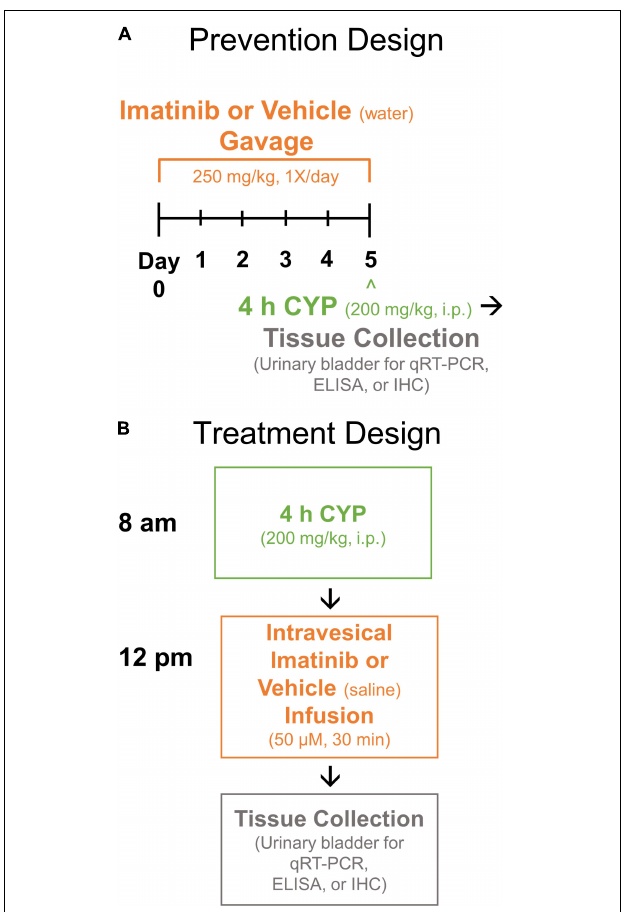
FIGURE 1 | Experimental designs. (A) Prevention design. Mice were pre-treated with imatinib mesylate (250 mg/kg) or vehicle (water) via oral gavage for 5 days, 1X/day. Mice received acute (4 h) cyclophosphamide (CYP) treatment (200 mg/kg, i.p.) on the 5th day. (B) Treatment design. Mice received acute (4 h) CYP (200 mg/kg, i.p.) followed 4 h later by imatinib (50 µ M) or vehicle (saline) treatment via transurethral intravesical